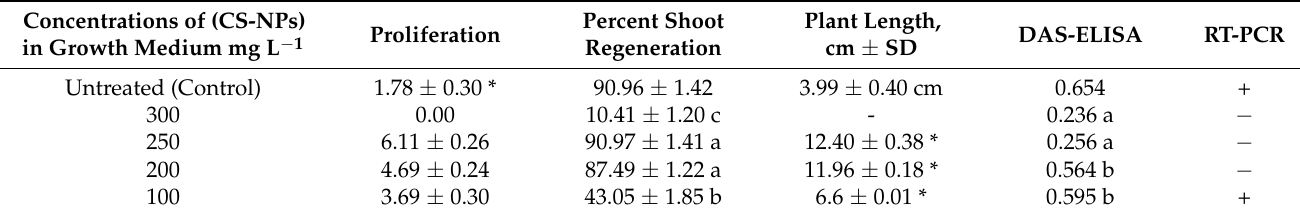
High phytotoxicity and no shoot regeneration response were observed when treated with 300 mg L − 1 (CS-NPs). Table 1. Effect of different concentrations of antiviral chitosan (CS-NPs) on shoot regeneration and the production of PVY-free potato plants ( Solanum tuberosum L.) cv. Spunta from infected potato sprouts. Concentrations of (CS-NPs)